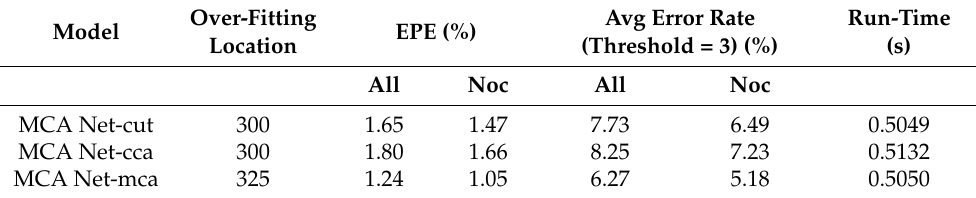
Table 2. Multi-cross attention module ablation experiment on KITTI2015. Over-Fitting Model MCA